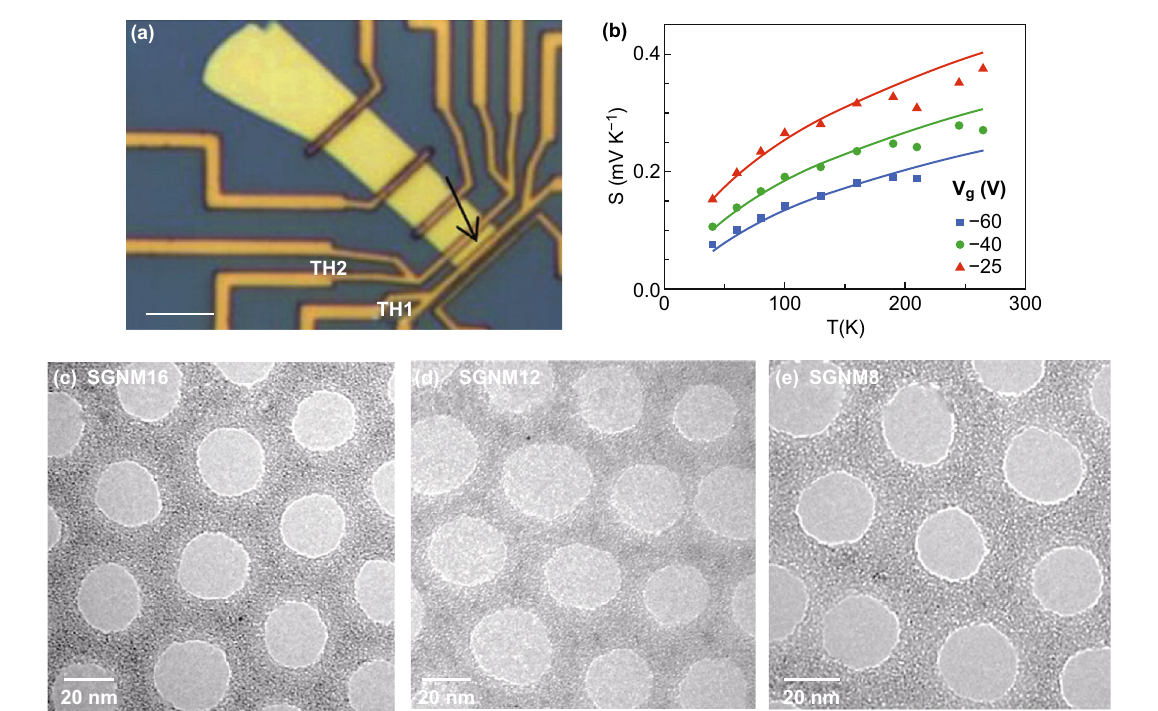
Fig. 15 a Optical microscope images of the measurement devices prepared onto a 300-nm-thick SiO 2 /Si substrates. b Seebeck coefficient of few-layer black phosphorus depending on temperature and gate voltage. Reproduced with permission from Ref. [131]. Copyright 2016, Ameri- can Chemical Society. c TEM image of single-layer graphene nanomeshes with neck width of 16 nm. TEM image of bilayer graphene nano- meshes with neck width of d 14 nm and e 8 nm. Reproduced with permission from Ref. [249]. Copyright 2017,